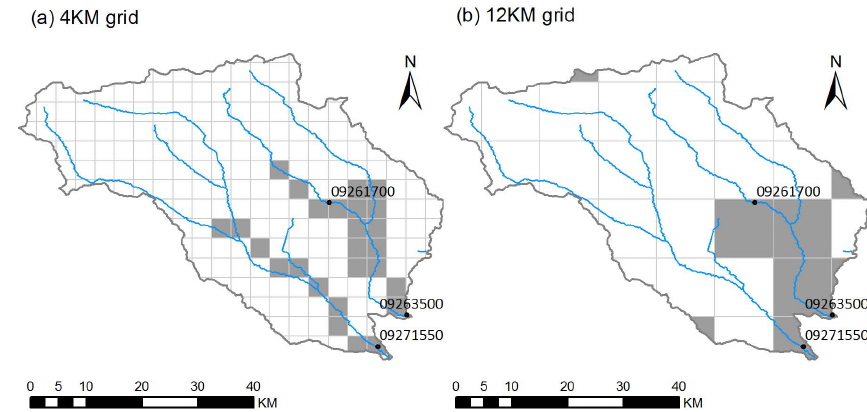
Fig. 1. Effect of spatial resolution in hydrologic